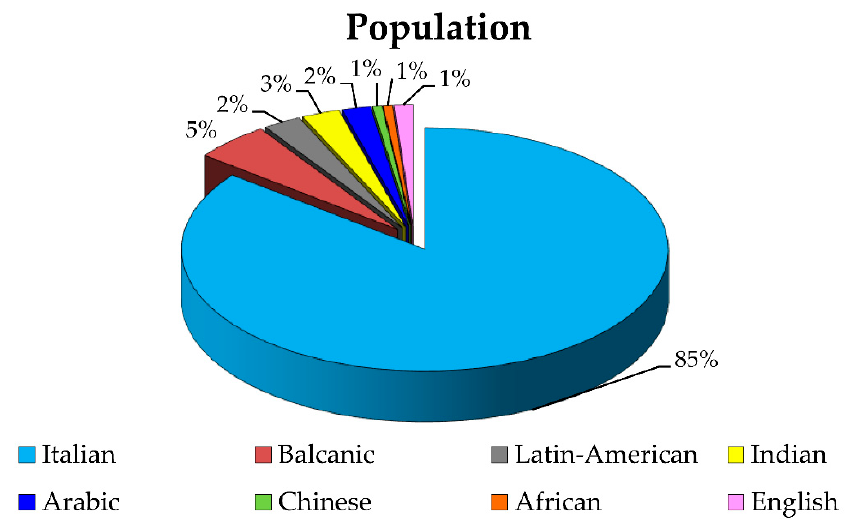
Figure 1. Ethnical distribution of the 158 analyzed patients.